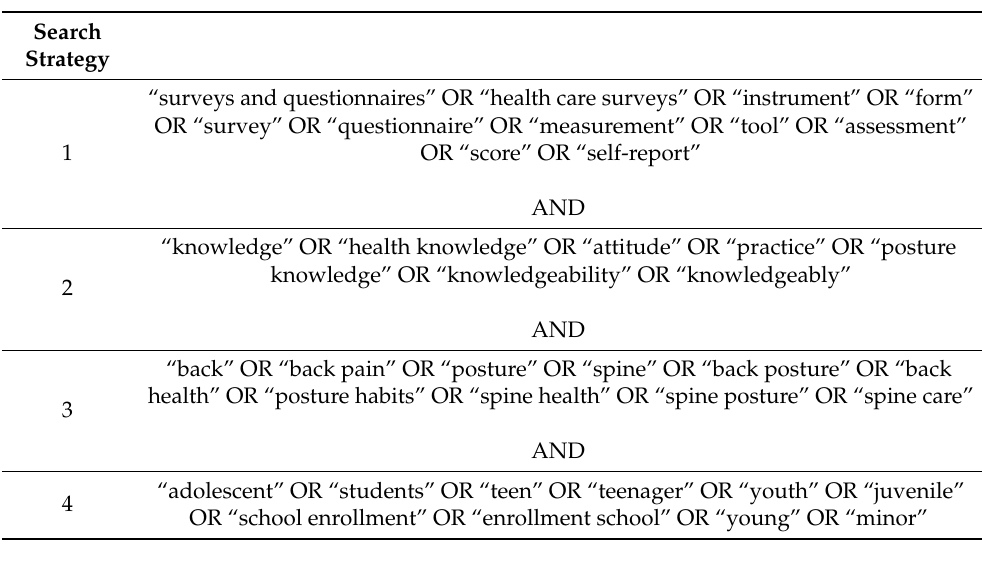
Table 1. Search strategy for the